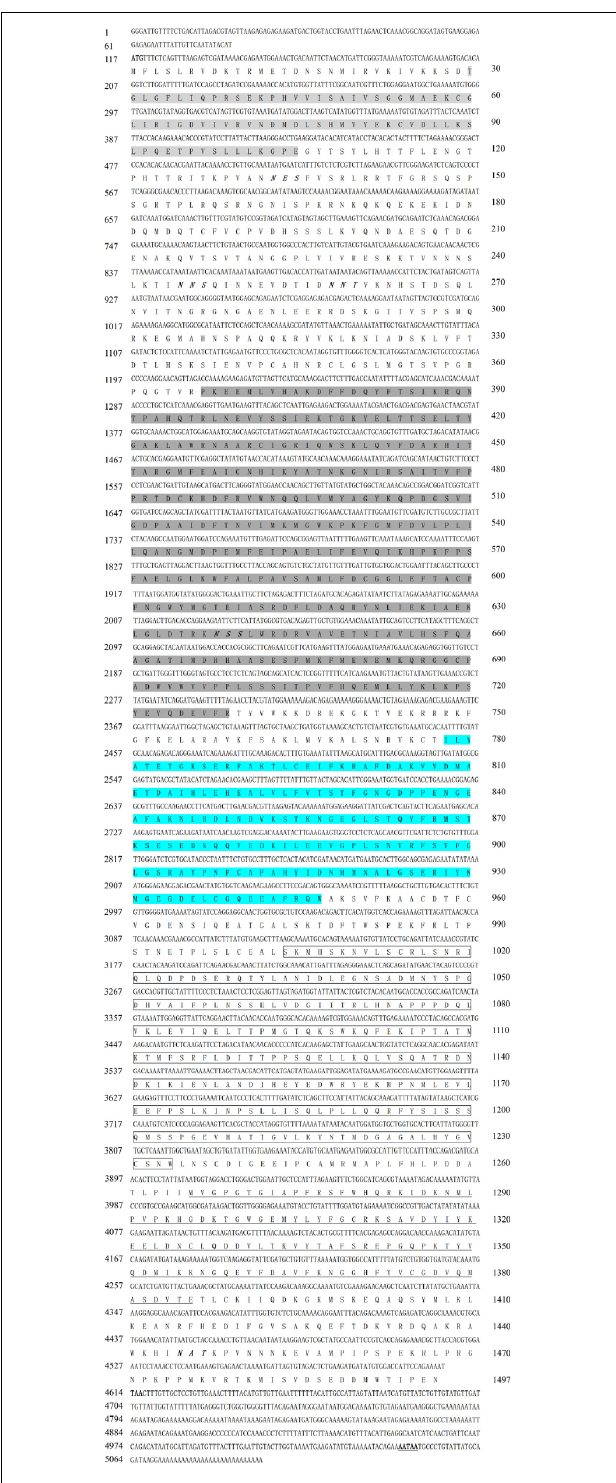
FIGURE 3 | Nucleotide and deduced amino acid sequences of McNOS. Start and stop codons are in bold, and the poly(A) tail is bold and underlined. The PDZ domain is shaded light gray. The NO synthase domain is shaded dark gray. The flavodoxin 1 domain is shaded blue. The FAD binding 1 domain is boxed. The NAD binding 1 domain is underlined. The five potential N-glycosylation sites (NXT) are bold and